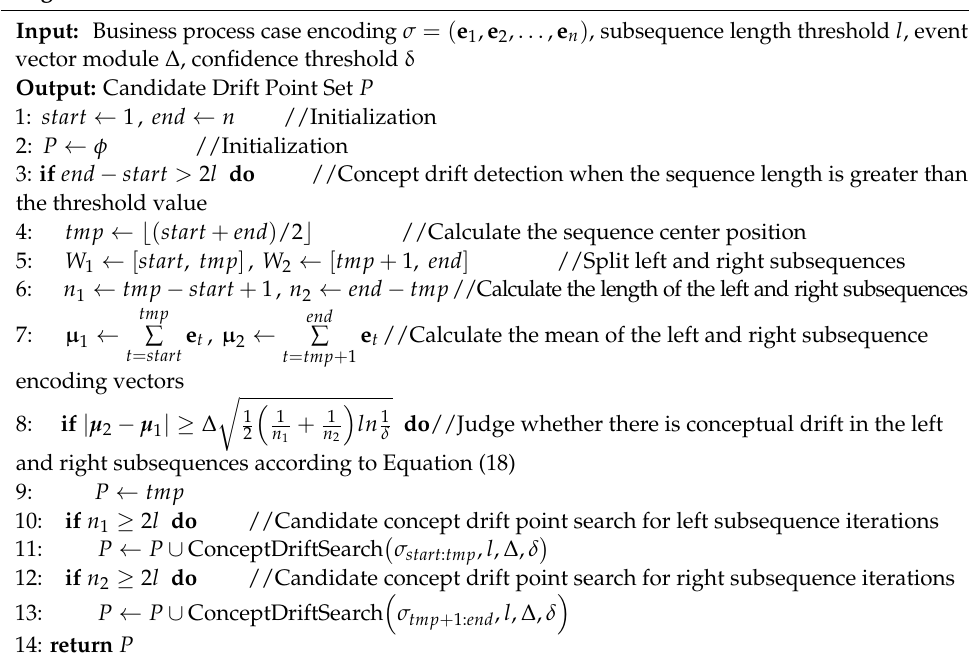
Algorithm 1 Candidate Drift Point